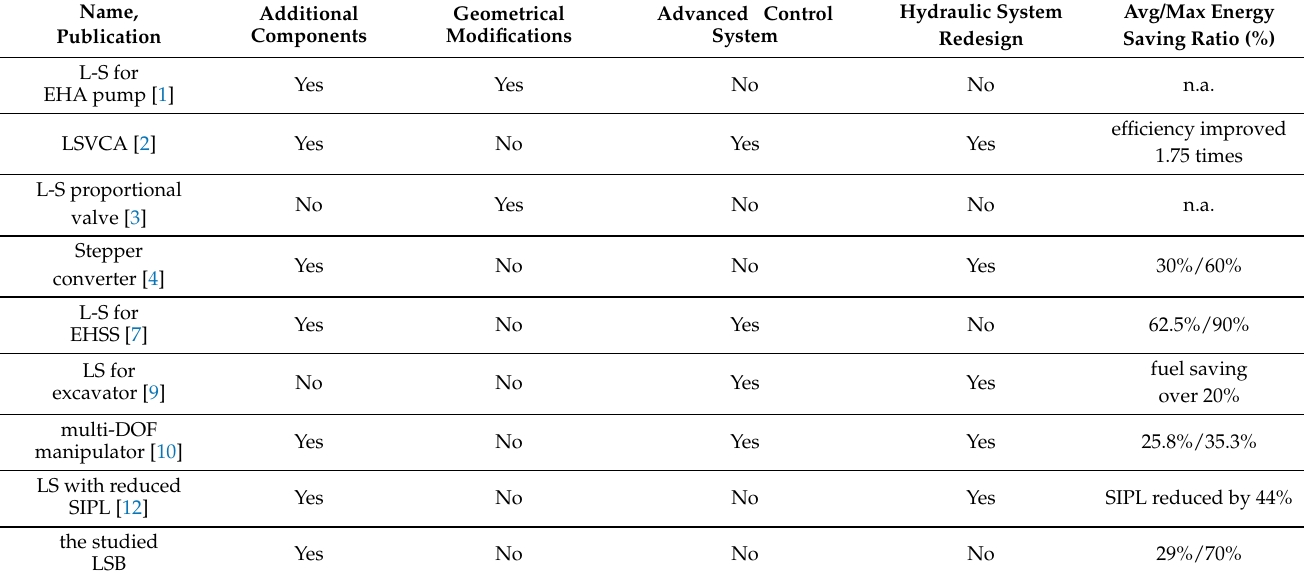
Table 6. Comparison of the features of load-sensing